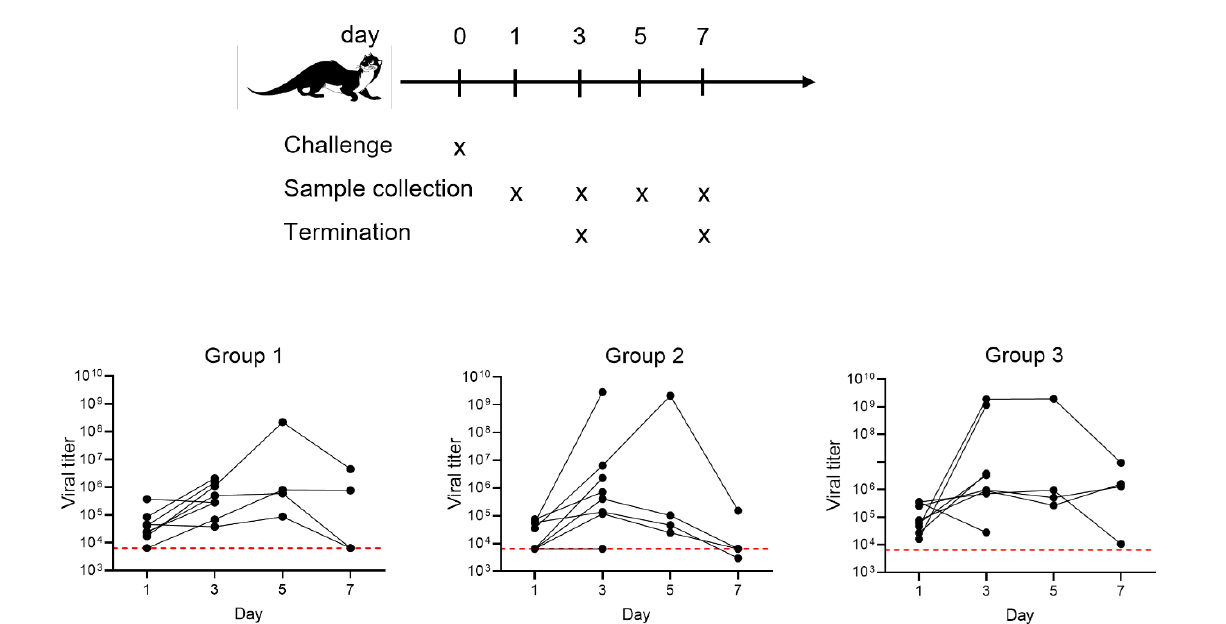
Figure 2. Detection of SARS-CoV-2 RNA in infected ferrets. Viral RNA in unvaccinated or COVID- e Vax-vaccinated ferrets was quantified by RT-PCR in nasal washes over time. The lines plotted are the geometric mean genome copies/mL. The red line indicates the lower limit of quantification (LLOQ).